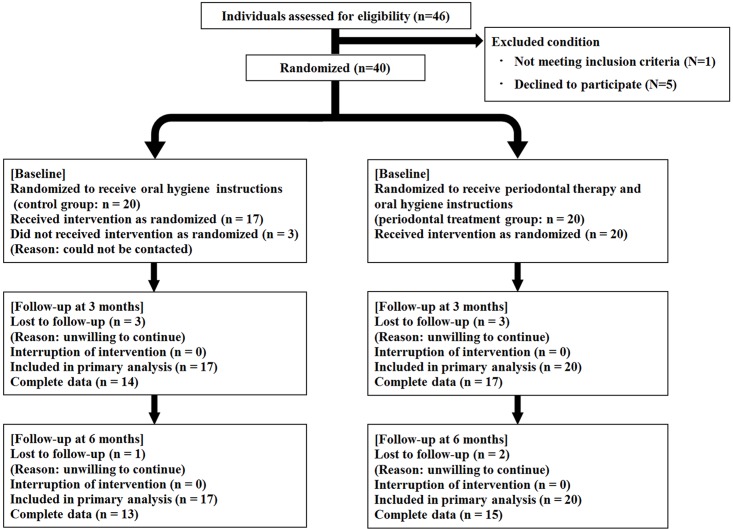
Flowchart of the study design.